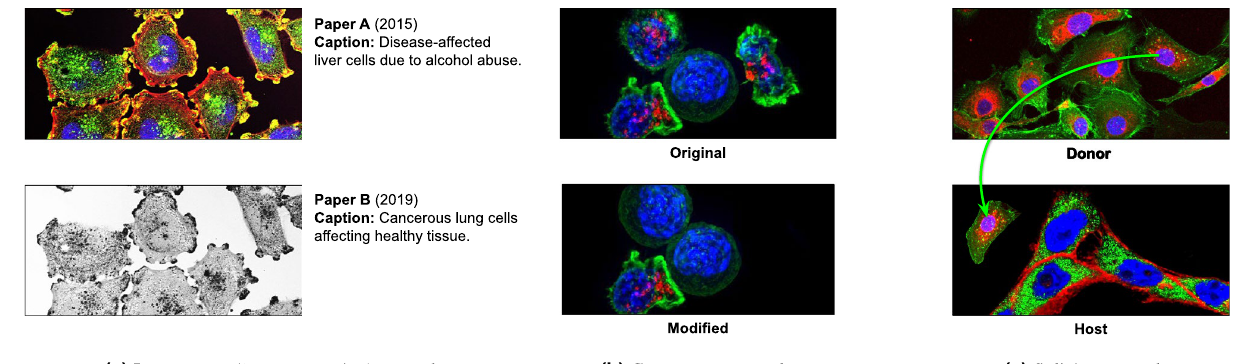
Figure 1. Image post-processing events commonly found in instances of scientific misconduct, which SILA targets. These examples were artificially generated for illustration’s sake. In ( a ), there is a case of image reuse. A culture published in 2015 and claiming liver cells (top) is repurposed in another publication in 2019, claiming lung cells (bottom). In ( b ), there is a case of content copy-move, where the original image on the top is modified to present fewer disease-affected cells (with red spots) at the bottom. Portions of the original content (healthy cell and background pixels) are duplicated to hide and remove undesired cells. In ( c ), there is content splicing. The green arrow points out the spliced cell from the image on the top to the one on the bottom, after rotation and resizing. All original images within this figure are in the public domain 3–6